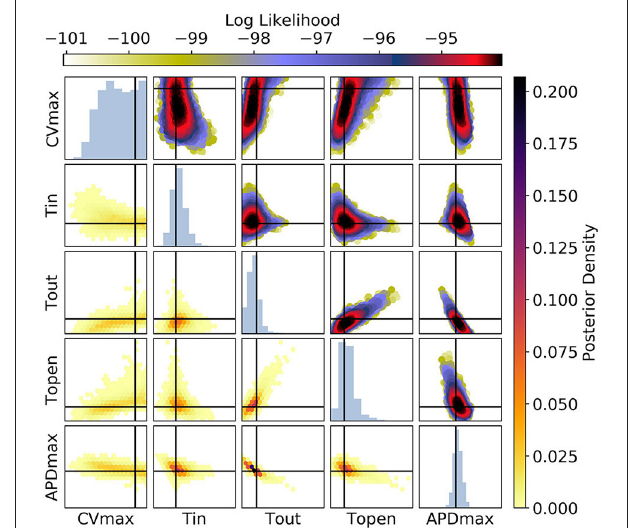
FIGURE 11 | The posterior parameter distribution for fits to APD(S2) and ERP(S1) measurements. The intersection of vertical and horizontal lines mark the true parameter value. The lower diagonal shows the density via hexbin plots, while the upper diagonal shows the log-likelihood values for each sample plotted in order of increasing likelihood. The diagonals show the marginal histograms of each